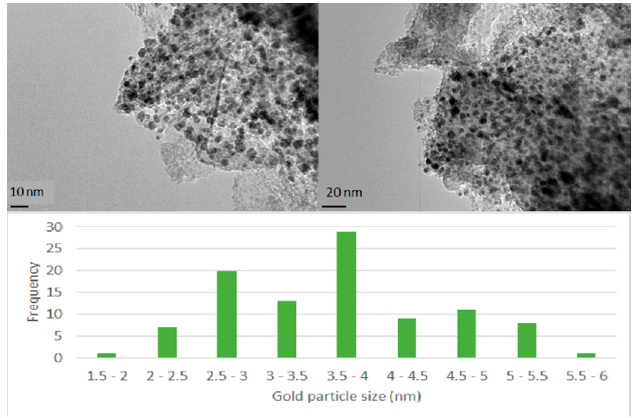
Figure 3. TEM images and particle size distribution from Au/HT 4:1.